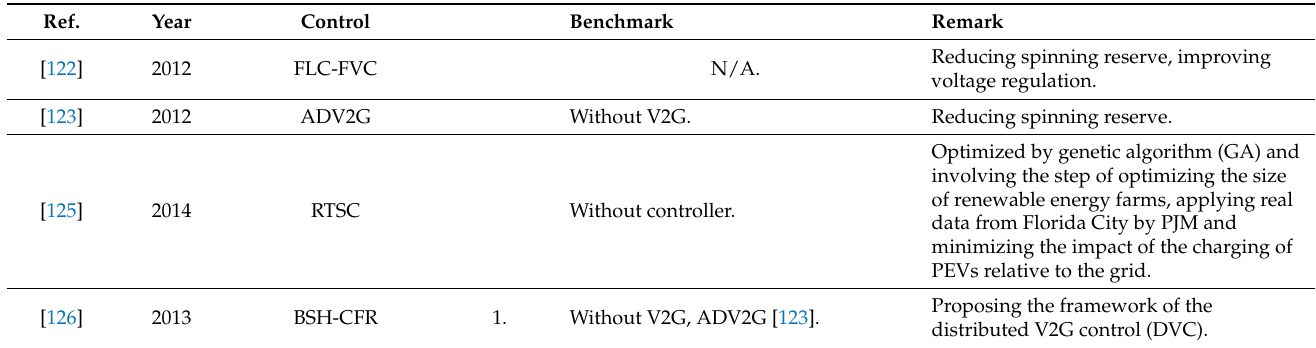
Table 1. EVAS as a frequency regulation